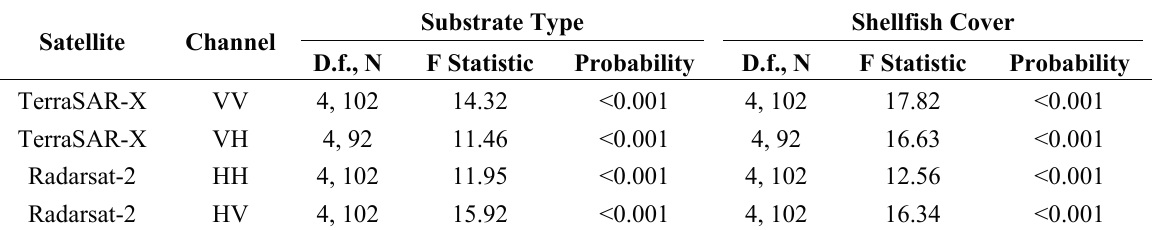
Figure 5. Plots with epibenthic shellfish significantly differed in backscatter from sediment and dispersed plots, but mussels, mixed and oysters do not differ significantly in backscatter. Letters indicate similar plots based on the Tukey HSD test. The dashed line indicates the average noise floor (noise equivalent sigma nought). Table 2. ANOVA statistics of backscatter between different types of substrates ( i.e. , sediment, mussels and oysters) and ANOVA statistics of backscatter between different cover classes (densities) of